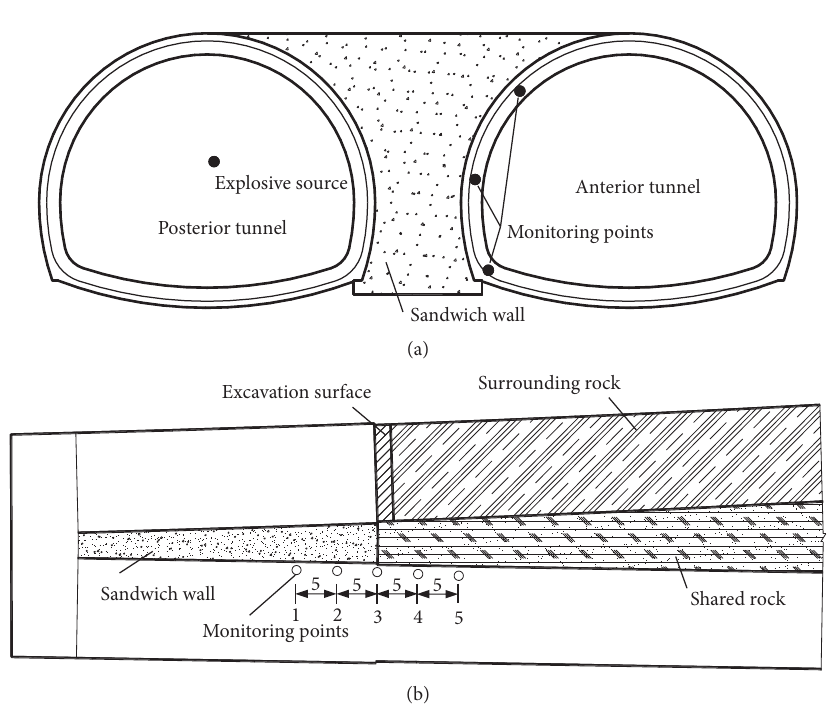
Figure 4: Layouts of vibration velocity monitoring points: (a) sectional layout; (b) plane layout (unit: